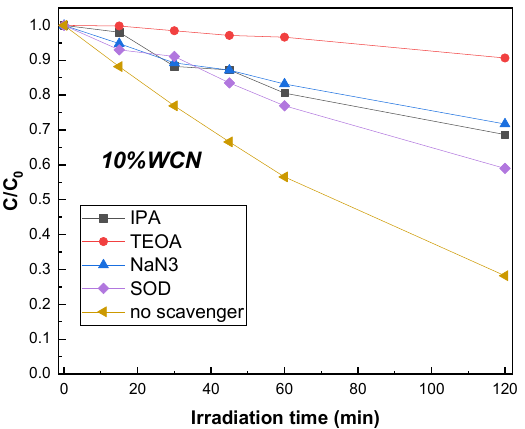
Figure 7. Scavenging experiments of phenol photocatalytic degradation under simulated solar light